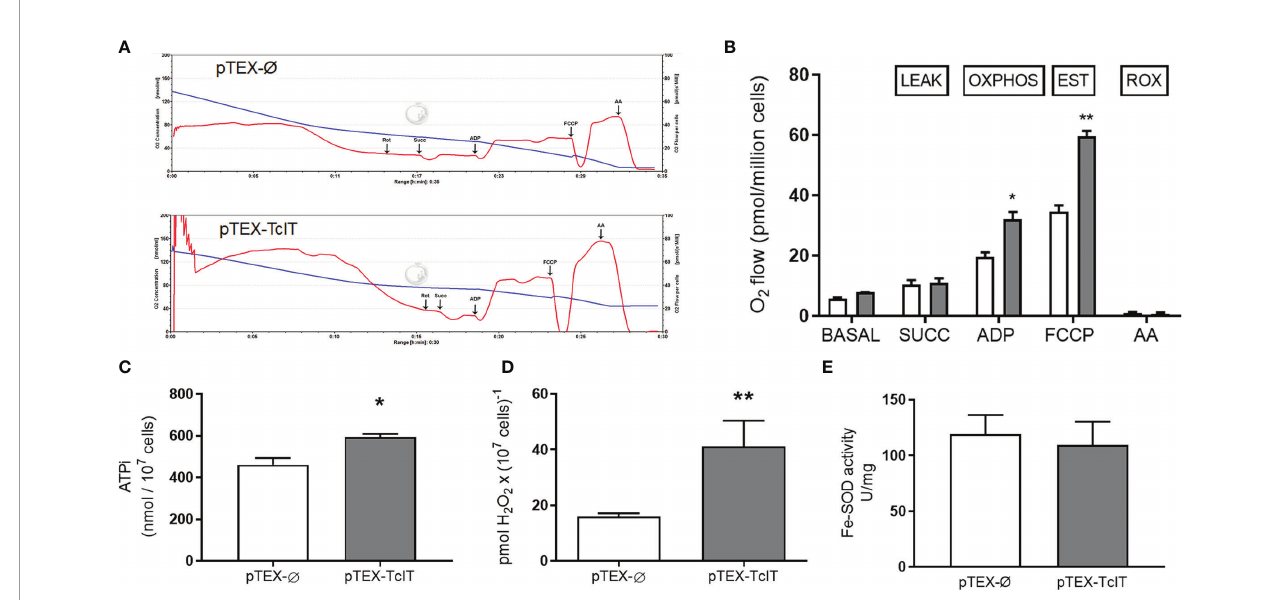
FIGURE 4 | Effect of TcIT overexpression on epimastigote mitochondrial physiology and Fe-SOD activity. (A) Representative recordings of O 2 consumption and decrease of O 2 concentration. Trypanosoma cruzi epimastigotes transfected with pTEX-Ø empty vector (upper panel) or pTEX-TcIT plasmid (lower panel) were initially tested for respiration of intact epimastigotes. Epimastigotes were then digitonin-permeabilized, as described in Nogueira et al. (2017), to measure mitochondrial activity after the successive additions indicated by arrows: Rot (rotenone), Succ (succinate), ADP, FCCP, and AA (antimycin A). (B) Graphic representation of O 2 consumption after the additions shown on the abscissa: SUCC, ADP, FCCP, and AA; ** P < 0.01, * P < 0.05 ( n = 4). (C) Intracellular ATP in T. cruzi epimastigotes transfected with pTEX-Ø empty vector (empty bar) or pTEX-TcIT plasmid (gray bar) was measured as described in M&M section. * P < 0.05 ( n = 3). (D) Production of H 2 O 2 by living cells of T. cruzi epimastigotes transfected with pTEX-Ø empty vector (empty bar) or pTEX-TcIT plasmid (gray bar); ** P < 0.001 ( n = 3). (E) SOD activity was assessed from epimastigotes transfected with pTEX-Ø empty vector (empty bars) or pTEX-TcIT plasmid (gray bars). The values represent the mean ± SEM. In (C – E) , using Student ’ s t -test assessed differences between mean values. In (B) , differences were assessed by two-way ANOVA followed by Tukey ’ s test. In all cases, the uncoupled respiration (with FCCP) was signi fi cantly higher than the respiration in phosphorylating conditions (with ADP). Both stimulated respiratory states were also signi fi cantly higher than those obtained only after addition of succinate (at least P < 0.05). No differences were found between the respiration of pTEX-Ø pTEX-TcIT epimastigotes in the presence of endogenous substrates or after the addition of